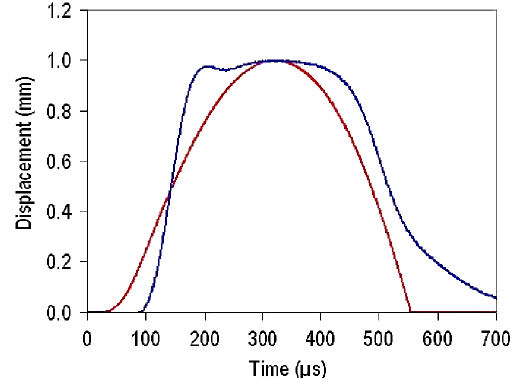
FIG. 13. Expanded view of Fig. 7 to show how the rise time of the gas is affected by charge voltage (coil